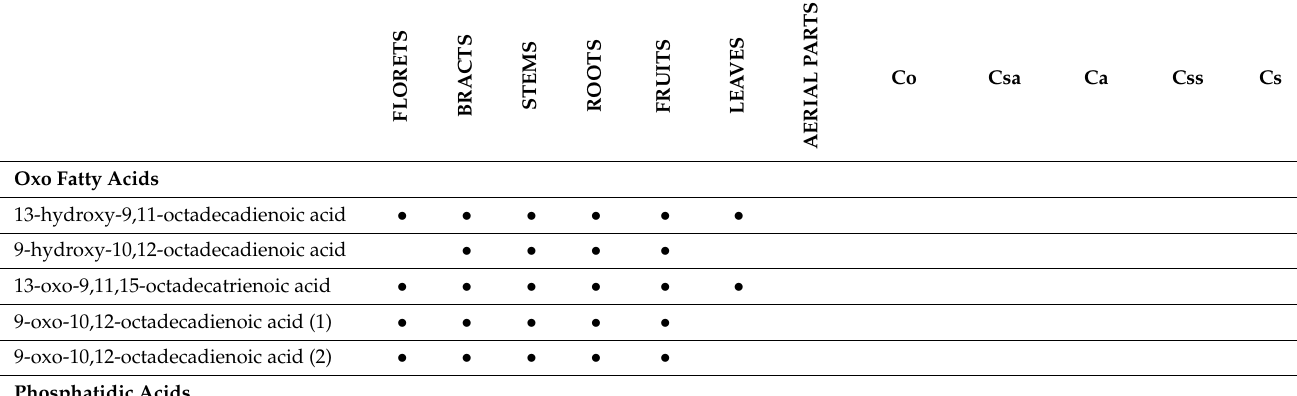
Table 5. Specialized metabolites of identified C. arvensis organs compared with literature. Our data ( • ), only literature data ( ○ ), and both sources ( ⦿ ). Co: C. officinalis ; Csa: C. suffruticosa subsp. algarbiensis ; Ca: C. arvensis ; Css: C. suffruticosa subsp. suffruticosa ; Cs: C. stellata (cid:35)